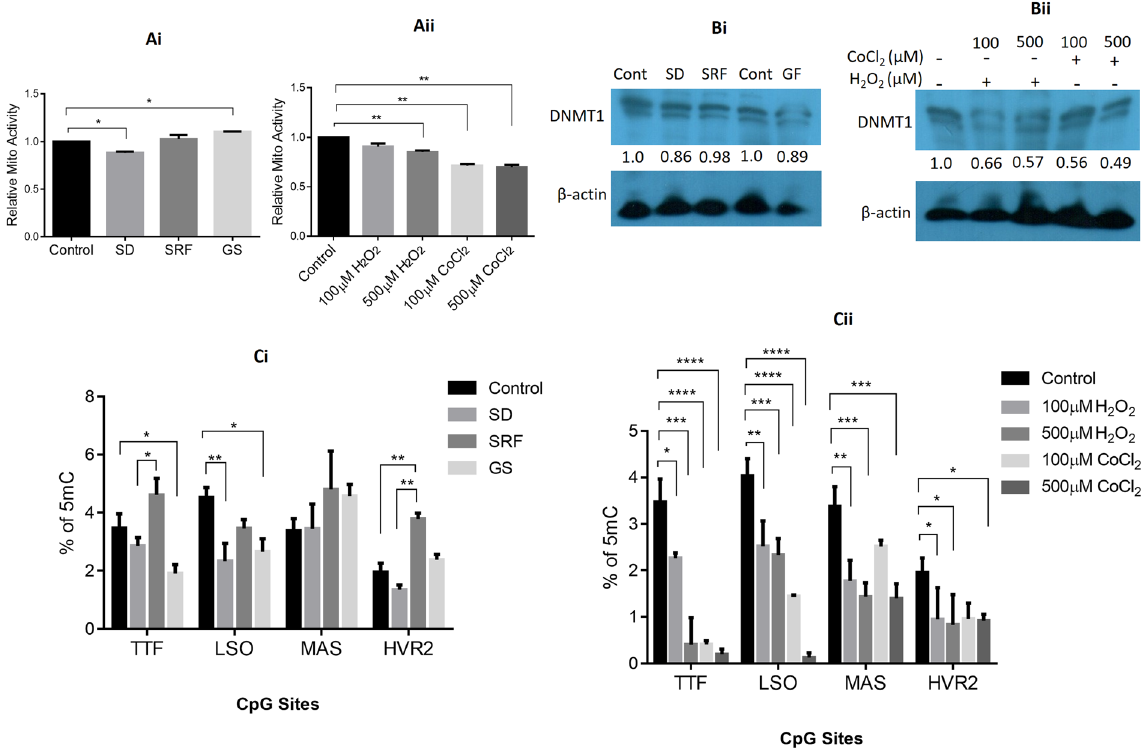
Figure 6. Mitochondrial DNA is hypomethylated under various conditions of nutritional and oxidative stress. ( A ) Relative mitochondrial activity in H1299 cells under different conditions of (i) nutritional and (ii) oxidative stress. ( B ) Western Blot scans of DNMT1 isoforms expression profile under (i) nutritional and oxidative (ii) stress conditions. ( C ) % of 5 mC at certain defined CpG sites of mitochondrial genome resulting from nutritional (i) and oxidative stress (ii) conditions respectively. SD, SRF and GF stands for serum deprivation, serum re-fed and glucose starvation respectively. H 2 O 2 and CoCl 2 treated and non-treated are indicated with ( + ) and ( − ) sign respectively. Relative fold of expression of DNMT1-isoform3 is calculated by densitometry analysis on normalization with respective β -actin expression and indicated (in values) just below the DNMT1